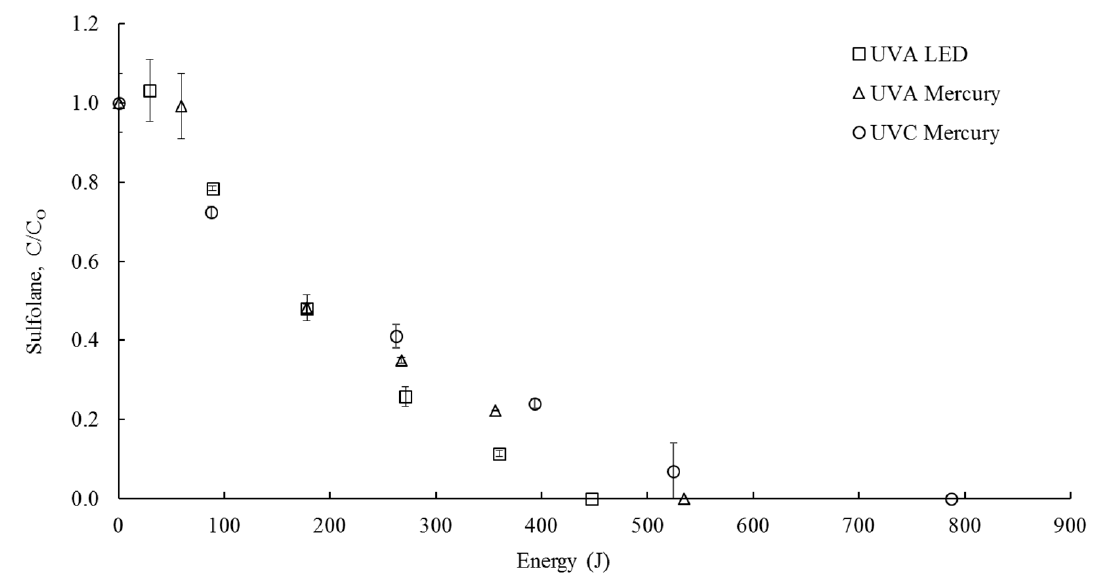
Figure 2. Photocatalytic degradation of sulfolane by 2 g/L of P25 using UVA-LEDs, UVA mercury lamps, and UVC mercury lamps.